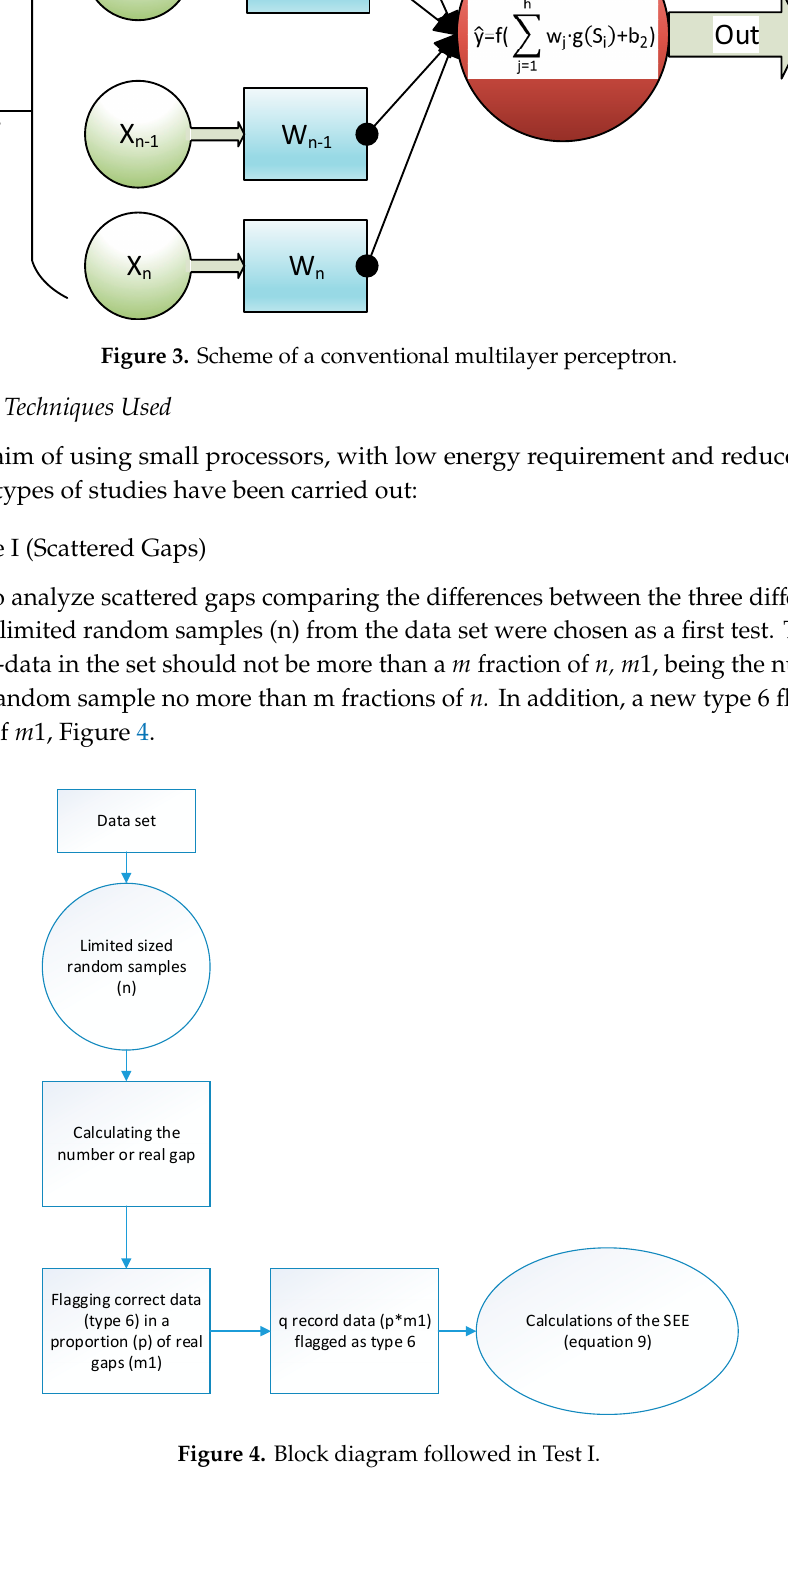
Figure 3. Scheme of a conventional multilayer perceptron.